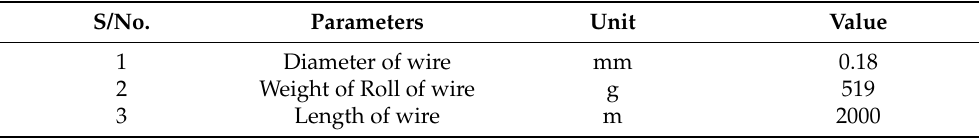
Table 6. Specifications of molybdenum